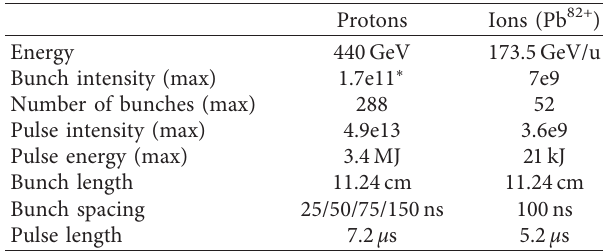
Figure 1: (a) LHC tertiary collimator impacted by 24 proton bunches, with an intensity of 1.3 × 10 11 p and energy of 440GeV [7]. (b) Comparison with a simulation performed with Autodyn and smoothed-particle hydrodynamics (SPH) technique [8]. Beam direction is Z . Table 1: HiRadMat beam parameters.